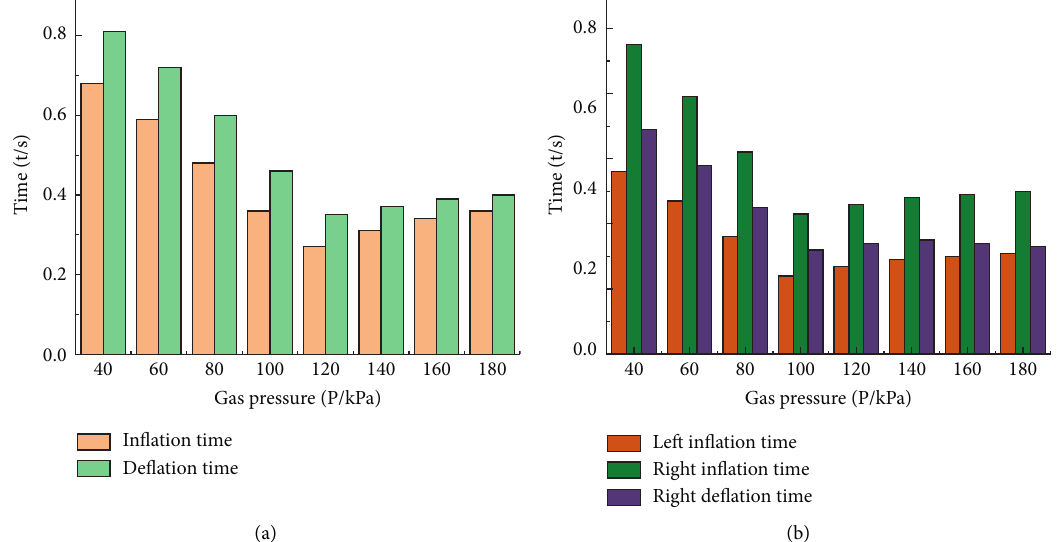
Figure 7: Motion cycle sequence diagram of pneumatic soft-bodied bionic basic execution unit. (a) Unidirectional basic execution unit. (b) Bidirectional basic execution unit.